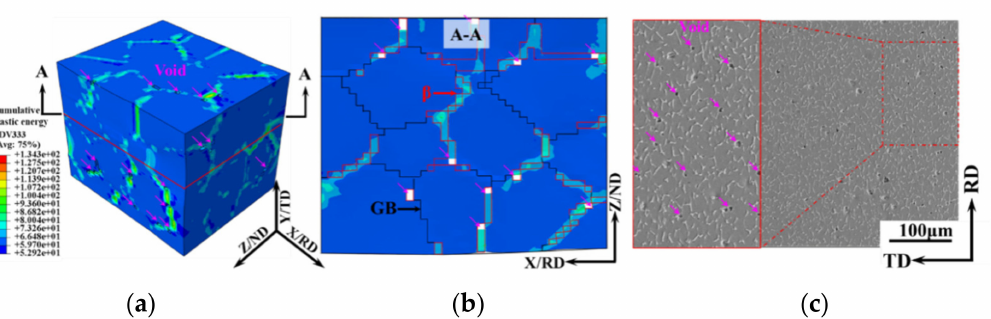
Figure 12. Simulated and experimental results of void distribution of the TA15 sheet during hot tension (750 ◦ C–0.1 s − 1 –true strain 0.1). ( a ) 3D map of simulated void distribution; ( b ) cross-section of A–A; ( c ) SEM map.